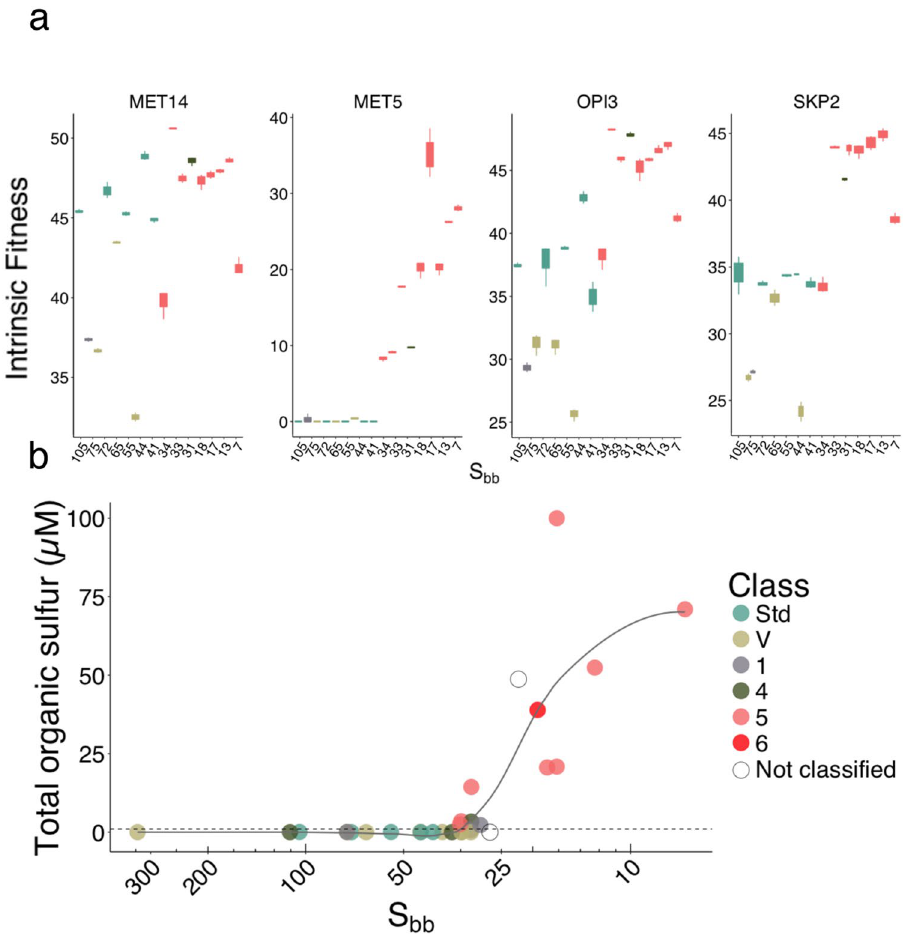
Figure 5. Growth profile of Saccharomyces cerevisiae strains impaired in their sulfur metabolism pathway in a subset of 2016 and 2017 samples. ( a ) Intrinsic fitness of the four mutant strains met14, met5, opi3 and skp2 in 2016 and 2017 saps. Colors represent quality classes. The horizontal axis present samples ordered by decreasing S bb . ( b ) Organic sulfur concentration in saps, as estimated by a standard curve of met5 intrinsic fitness in methionine, varies along the sample S bb and coincides with quality. The line represents the loess regression curve between the estimated organic sulfur concentration and the S bb